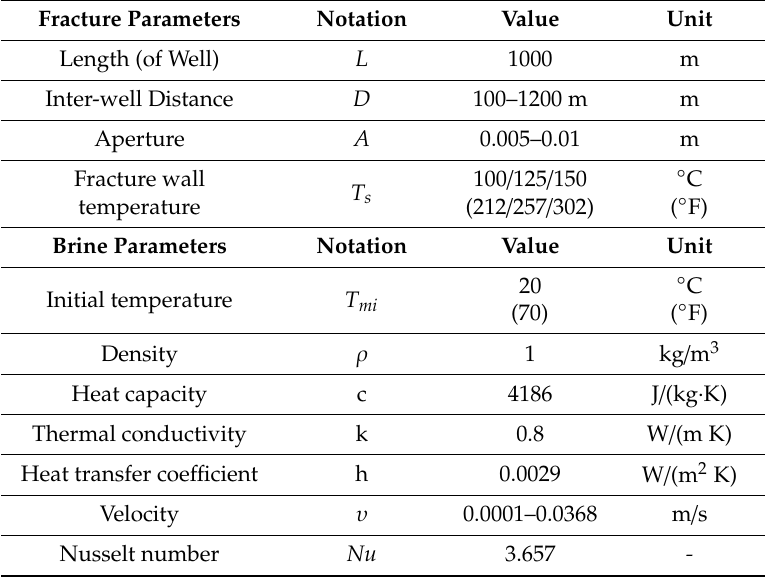
Figure 5. Texas climograph data in 2016. The blue line is the average low temperature of each month, and the red line is the average high temperature of each month. The blue bars give the relative average monthly precipitation (Reproduced with permission from [39]). Table 1. Parameter values used for the uniform surface temperature case (Mechanism 1).